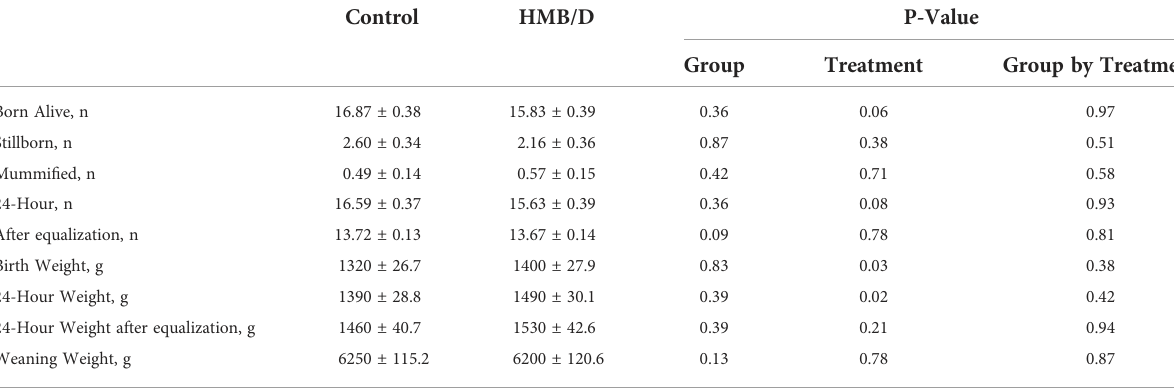
TABLE 2 The effect of supplementing calcium beta-hydroxy-beta-methylbutyrate and vitamin D (HMB/D) during late gestation and lactation on number of piglets per sow in trial 1. a Control